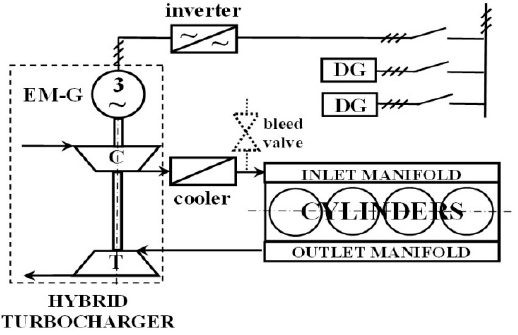
Figure 4. Scheme of the proposed engine with hybrid turbocharger.